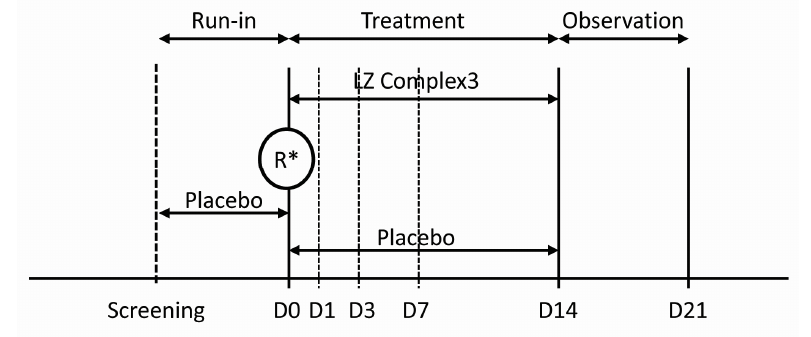
Figure 1. Study design. R * = randomization; D = study day.